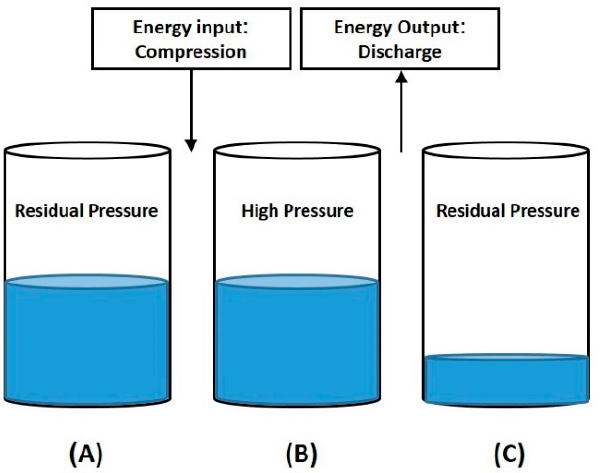
Figure 3. Different states of the high-pressure tank during the process of charging and discharging, assuming that it is